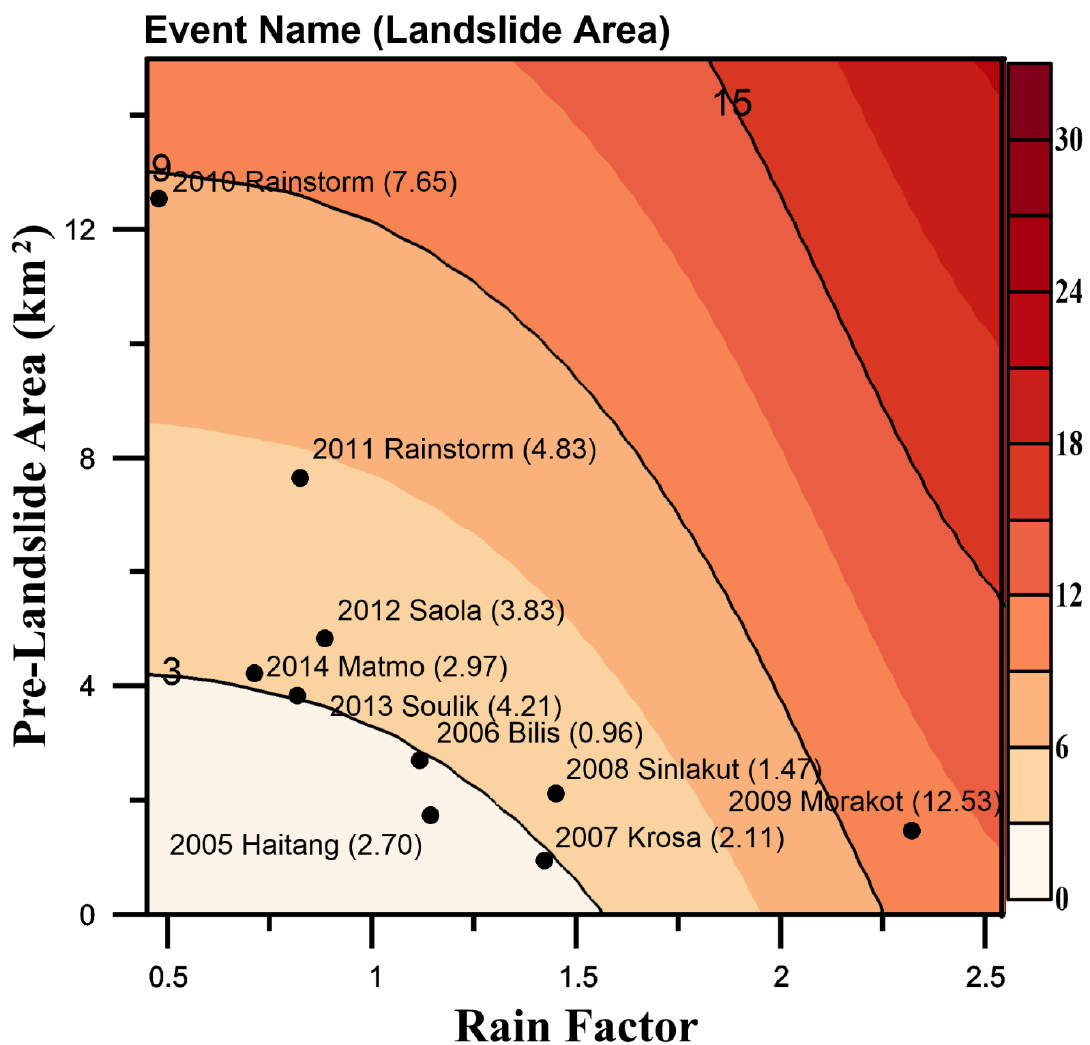
Figure 8. Total landslide area as a function of total landslide area in the previous year (pre-landslide area on the y -axis) and rain factor (i.e., R/R* on the x -axis, please refer to Equation (5)). Total landslide area (the filled contour) is derived from the landslide model in this study. The dots represent the observed landslides for the 9 events with their area in brackets.